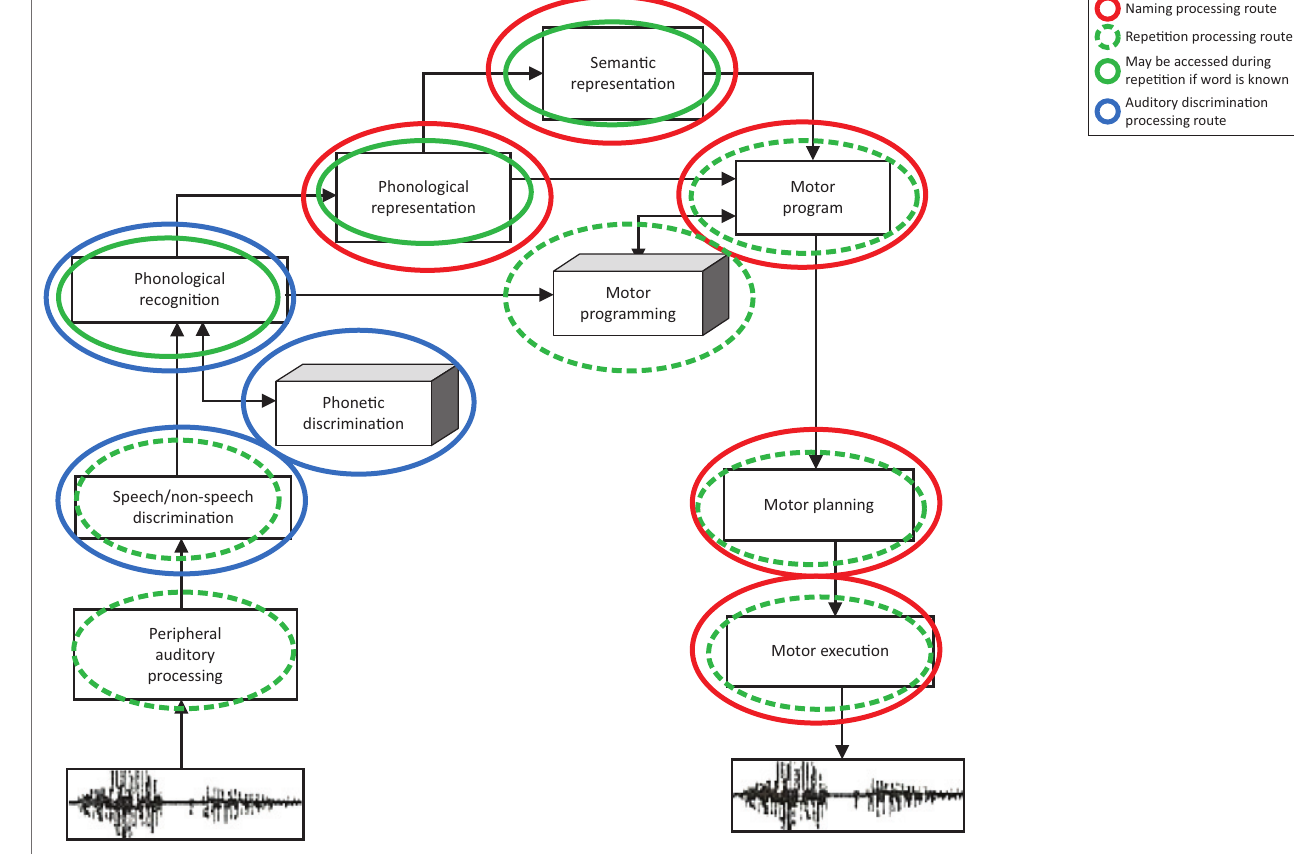
FIGURE 2: Information processing model showing processing pathways for three